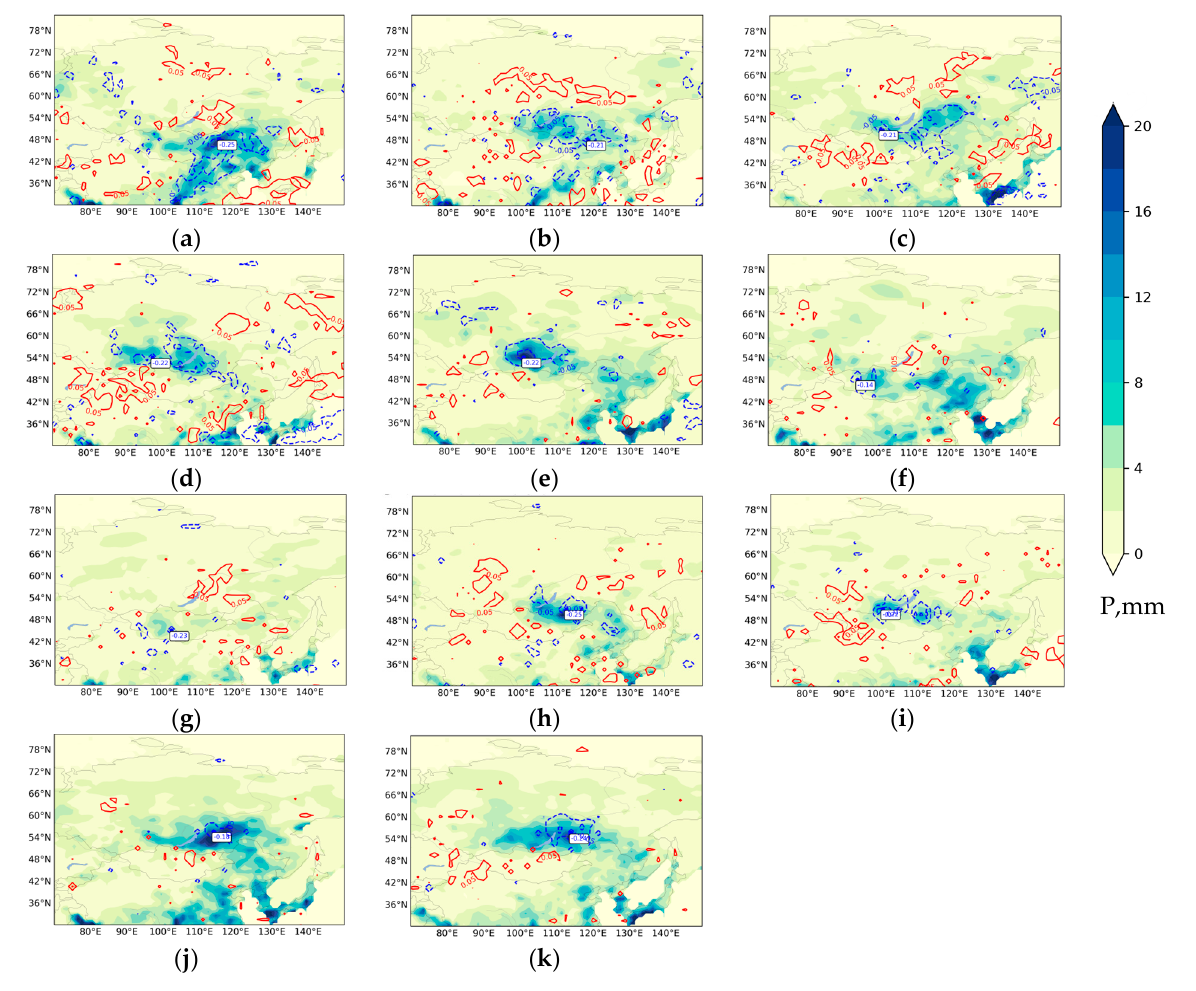
Figure 2. The average precipitation (P, mm) and anomalies of vertical velocity at 500 hPa (90% confidence level). The dashed blue lines show increasing ascending motions, and solid red lines show descending motions. The white rectangle shows the maximum increase in ascending motions.